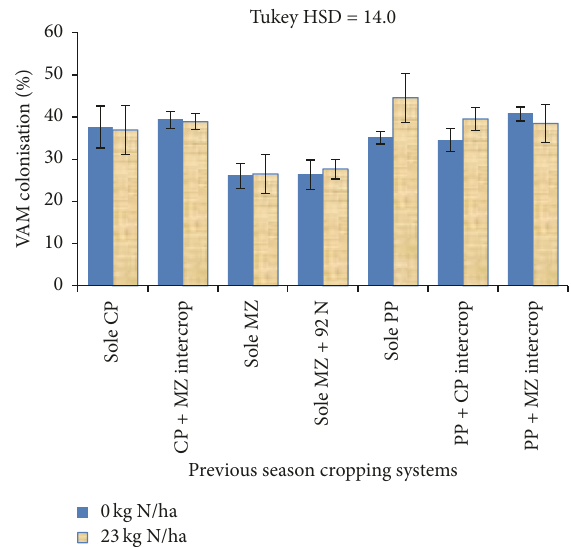
Figure 3: VAM colonisation of maize roots as influenced by previouscroppingsystemsandNfertilizerapplicationforDowasite. Key . Each error bar represents a standard error of the mean; CP = cowpea; MZ = maize; PP = pigeon pea; 92N = 92 kg Nha −1